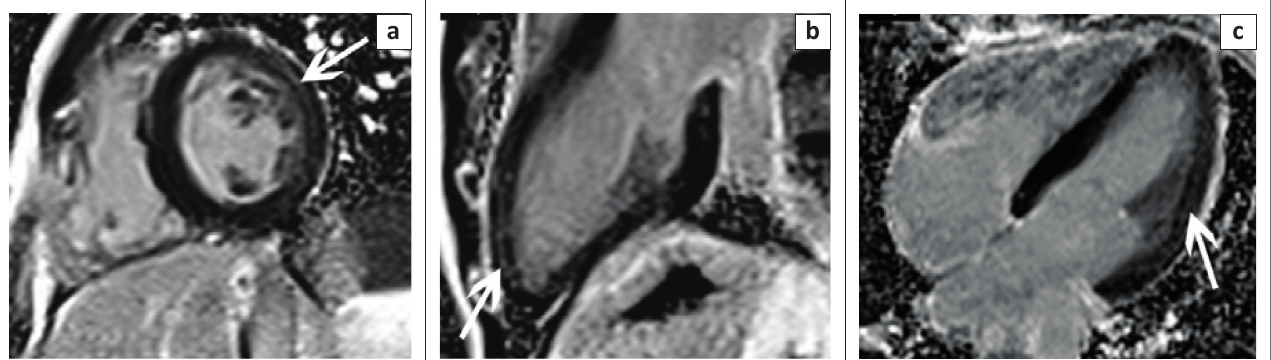
FIGURE 3: Short-axis (a), 2-chamber (b) and 4-chamber (c) late gadolinium phase-sensitive inversion recovery images show linear mid-wall enhancement in the lateral wall of the LV (white arrows).